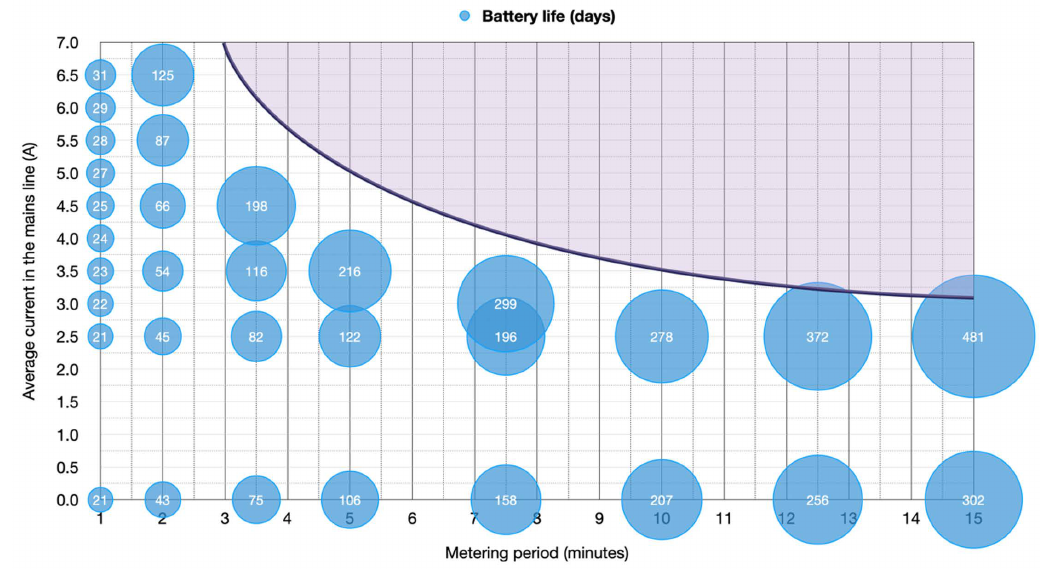
Figure 17. Graphical summary of battery life depending on metering period and effective average current in the mains electrical line.